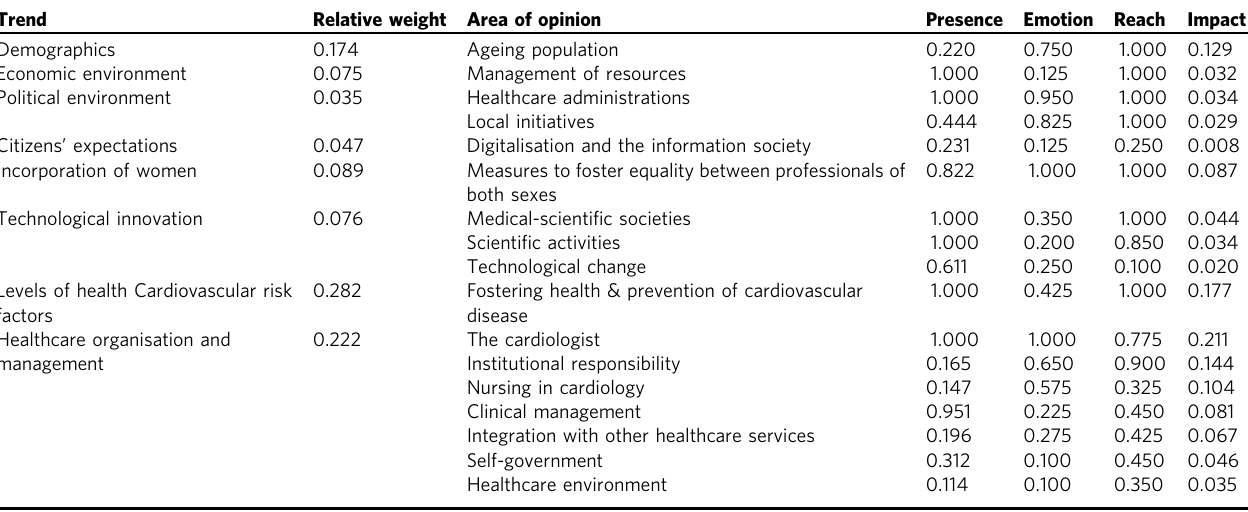
Table 1 The impact of areas of opinion related to the most relevant trends for the future of cardiology identi fi ed by the Spanish Society of